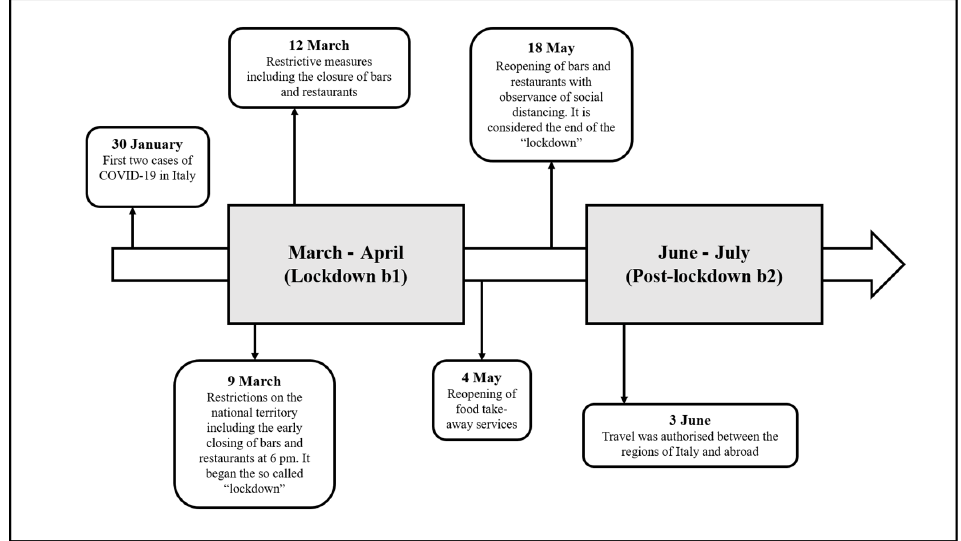
Figure 1. Timeline with the events occurring in Italy during the COVID-19 pandemic relevant for this study in 2020.